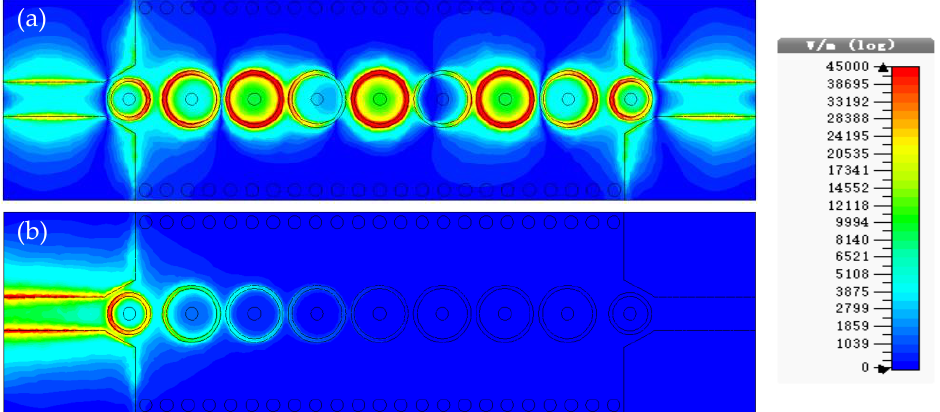
Figure 8. ( a ) Simulated electric field distributions of the second BPF example based on the proposed SSPP at 20 GHz. ( b ) Simulated electric field distributions at 7 GHz.